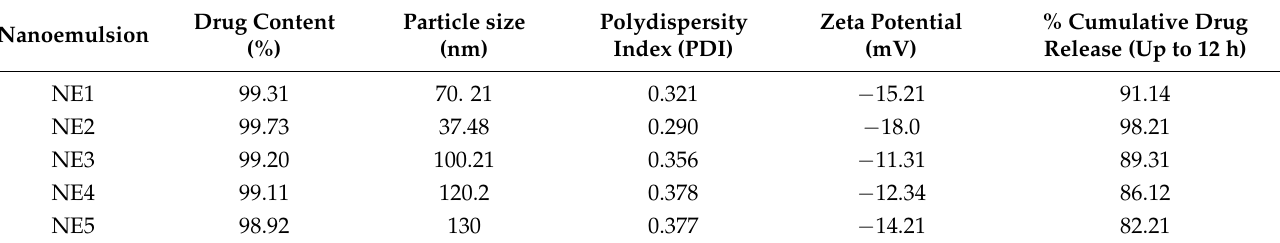
Table 3. Various characteristics of stable nanoemulsions.